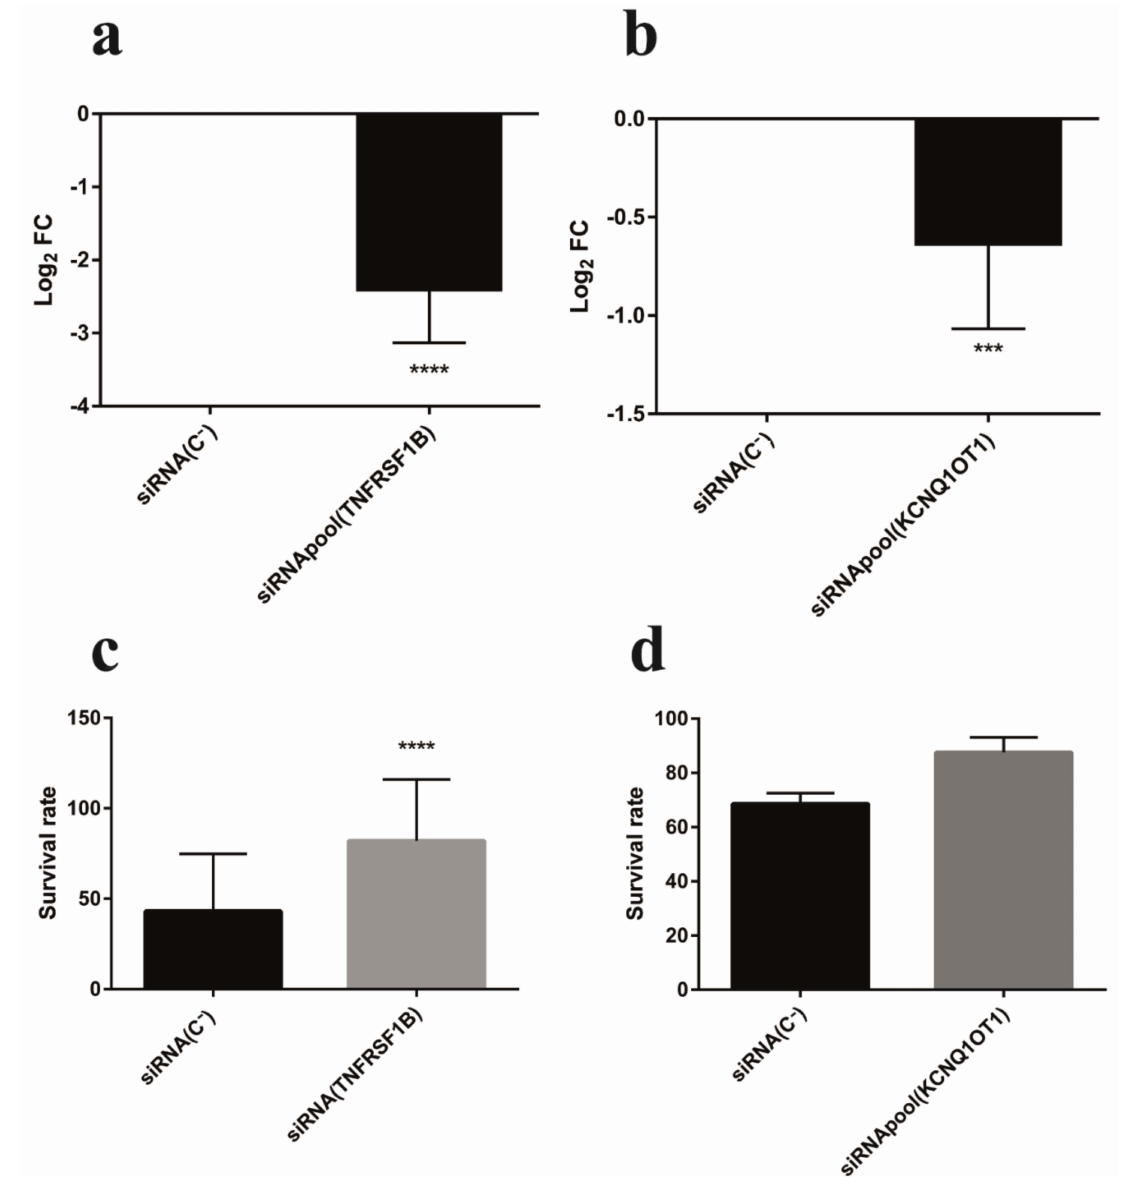
Figure 4. Functional validation of individual siRNA target transcripts: TNFRSF1B and KCNQ1-OT1. siRNA pools targeting TNFRSF1B ( a ), and KCNQ1-OT1 ( b ), reduce their respective transcript levels in 6CFSMEo- cells. Log 2 FC values of 6CFSMEo- cells transfected with optimized siRNA pools, compared with control (6CFSMEo- cells transfected with a non-targeting siRNA sequence (siRNA(C-)). Data are expressed as means ± SD. n = 8, with three technical replicates/each. *** p < 0.001; **** p < 0.0001 compared to the control. Spectrophotometric quantification of the mean survival rate of the siRNA control non-target (siRNA(C-)) and the siRNA pools against TNFRSF1B ( c ), and KCNQ1-OT1 ( d ), transcripts in 6CFSMEo- cells in the presence of 1.2 mM H 2 O 2 at 4 days after adding Alamar Blue reagent. Data are expressed as means ± SD. n = 5, with 8 Table 1. B; n = 2, with four technical replicates/each for KCNQ1-OT1. **** p < 0.0001, compared with the